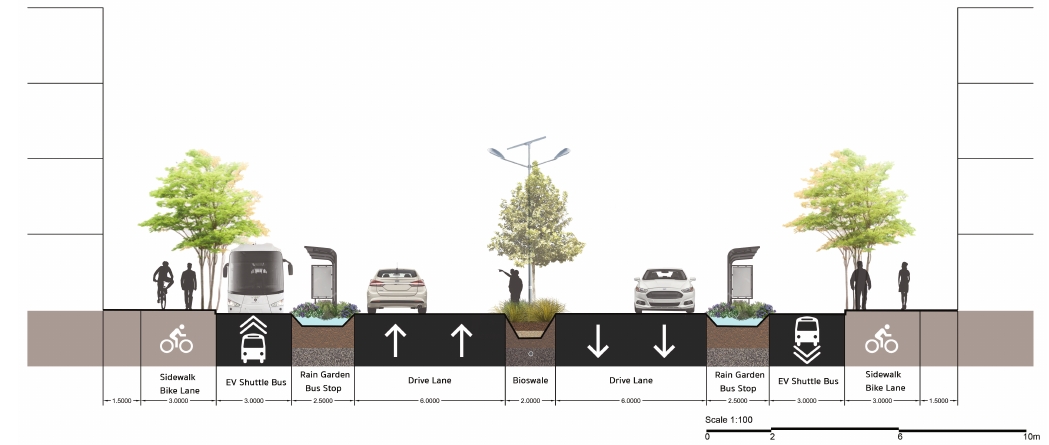
Figure 15. Smart Mobility vision for the main east–west corridor of Nava Nakorn with public transit, private automobile roads, sidewalks, bicycle paths, and bioswales for stormwater drainage.